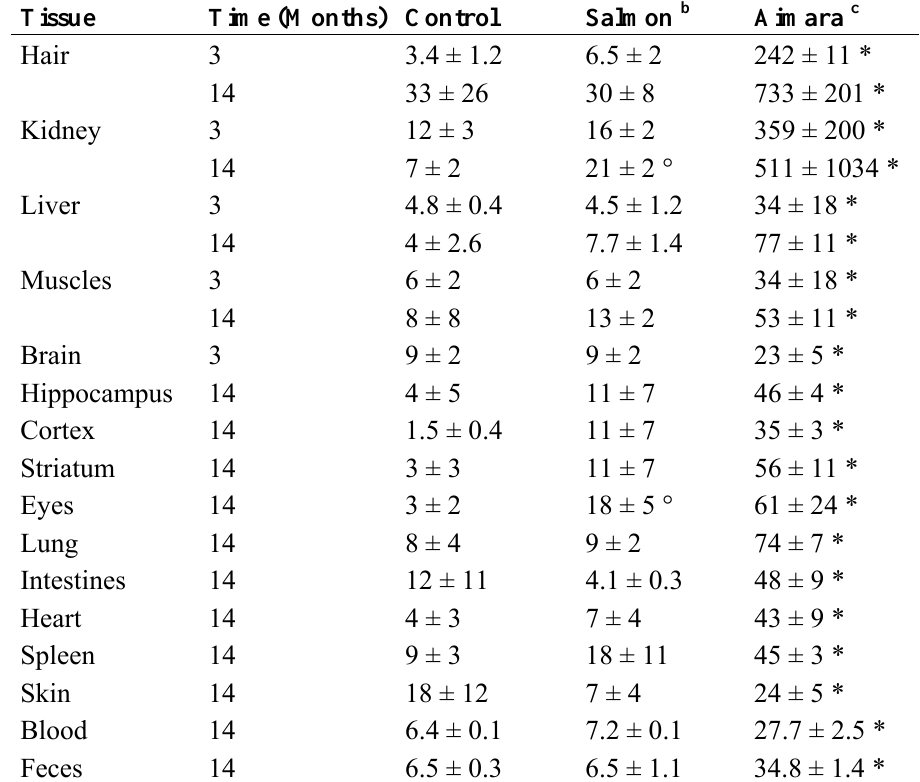
Table 5. Mercury bioaccumulation in tissues from mice fed fish-containing diets for 14 months a .